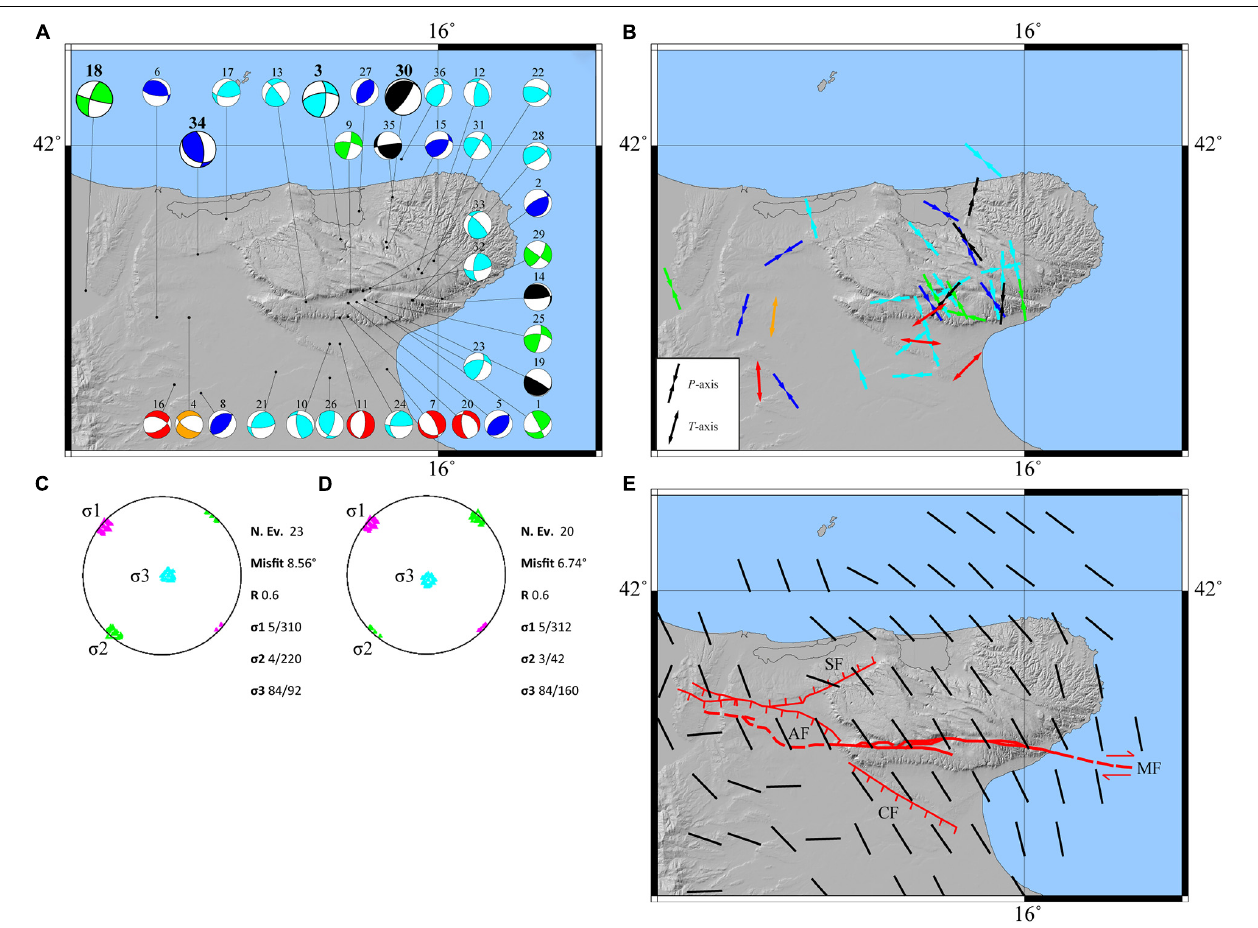
FIGURE 5 | (A) Distribution on map of the 36 average focal mechanisms computed from our data. The different color identifies the kinematics according to the guidelines of the World Stress Map (Heidbach et al., 2016). Red, NF ; Orange, NS ; Green, SS ; Cyan, TS ; Blue, TF ; Black, U . Focal mechanisms dimensions are scaled according to magnitude ranges (small for Ml < 3; big for Ml ≥ 3). (B) P-T axes distribution and orientation on map. Arrows represent P-T axes and colors refer to the Heidbach et al. (2016). P -axes are reported for TF , TS , SS , and U kinematics, while T -axes are reported for NF and NS kinematics. (C) The stress axis on the stereo-net with confidence regions for each principal stress axis for 23 focal mechanisms; π and τ angles of σ are reported. (D) The same as (C) for 20 focal mechanisms as described in the Error Propagation and Validation section. (E) Stress data interpolation provided with SHINE code (Carafa et al., 2015a). Thick black bars represent the S Hmax computed by using our 36 focal